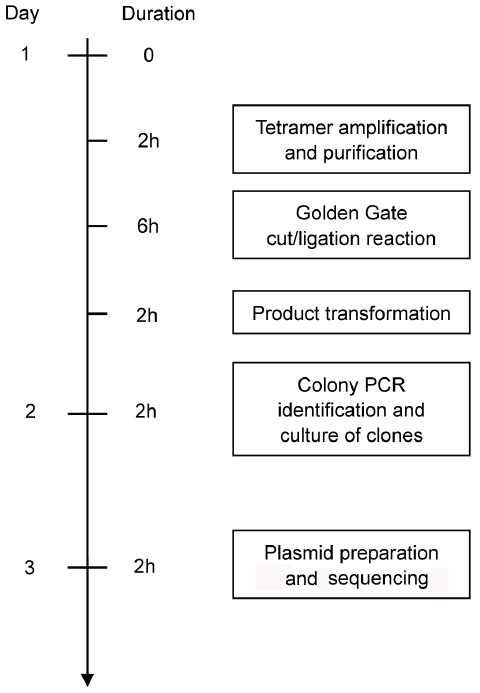
Figure 1. Timeline for the construction of TALE constructs. Steps of the construction of TALENs and TALE-TFs are presented. TALE constructs can be generated in 3 days following the described steps. Samples of each step can be stored at 2 20 u C for further